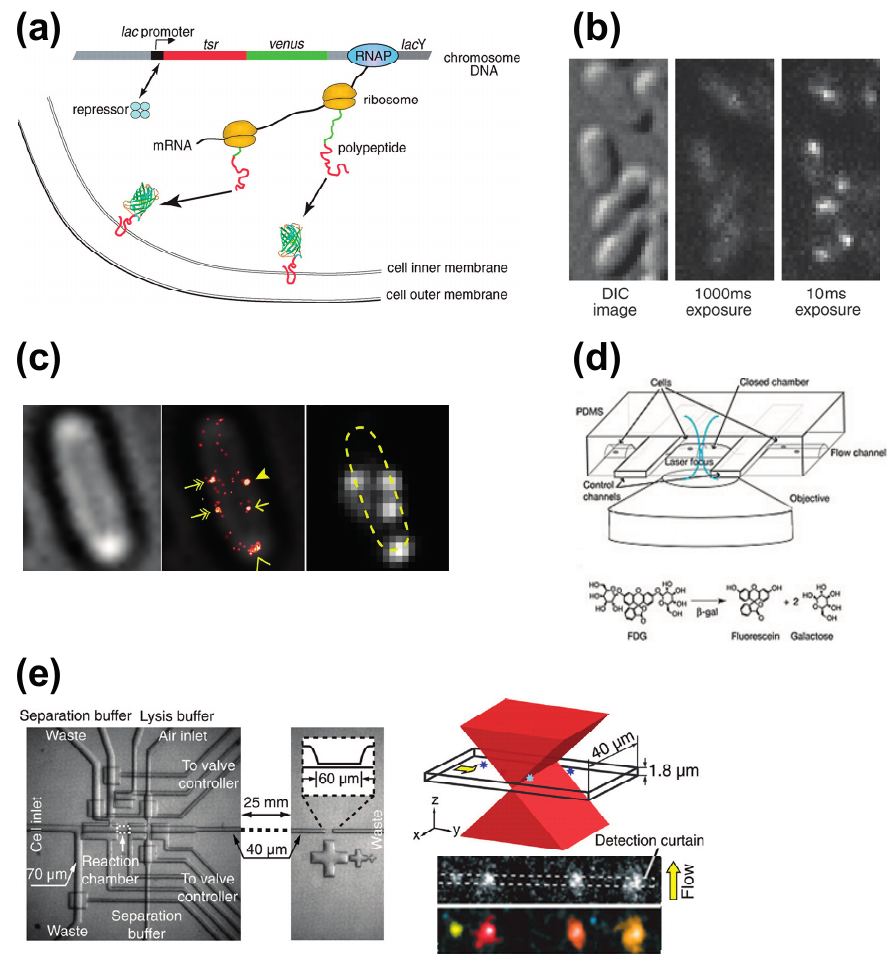
Figure 3. Selected methods for single cell protein expression analysis. ( a ) Single molecule detection of protein expression at the membrane. The inclusion of a membrane protein (Tsr) into the gene assures the protein of interest will be localized at the membrane, while the inclusion of a fluorescent protein (Venus) into the gene assures detection of the membrane localization [10]. ( b ) Stroboscopic detection of single fluorescent proteins in single E. coli cells [37]. ( c ) Counting the number of FliM-Dendra2 in a E. coli cell with PALM/STORM. Bright-field image, super-resolution Flim-Dendra2 overlay image and diffraction-limited Flim-Dendra2 image are shown [41]. ( d ) Microfluidic system for monitoring single reporter molecules with the enzymatic assay. Schematic diagram of fluorogenic enzymatic reactions is shown on the bottom [9]. ( e ) Single-cell analysis chip. Schematic diagram of the molecule detection section illuminated by a focused excitation laser is shown on the top right. Examples of recorded frames are shown on the bottom right [43]. Images are taken from [9,10,37,41] and